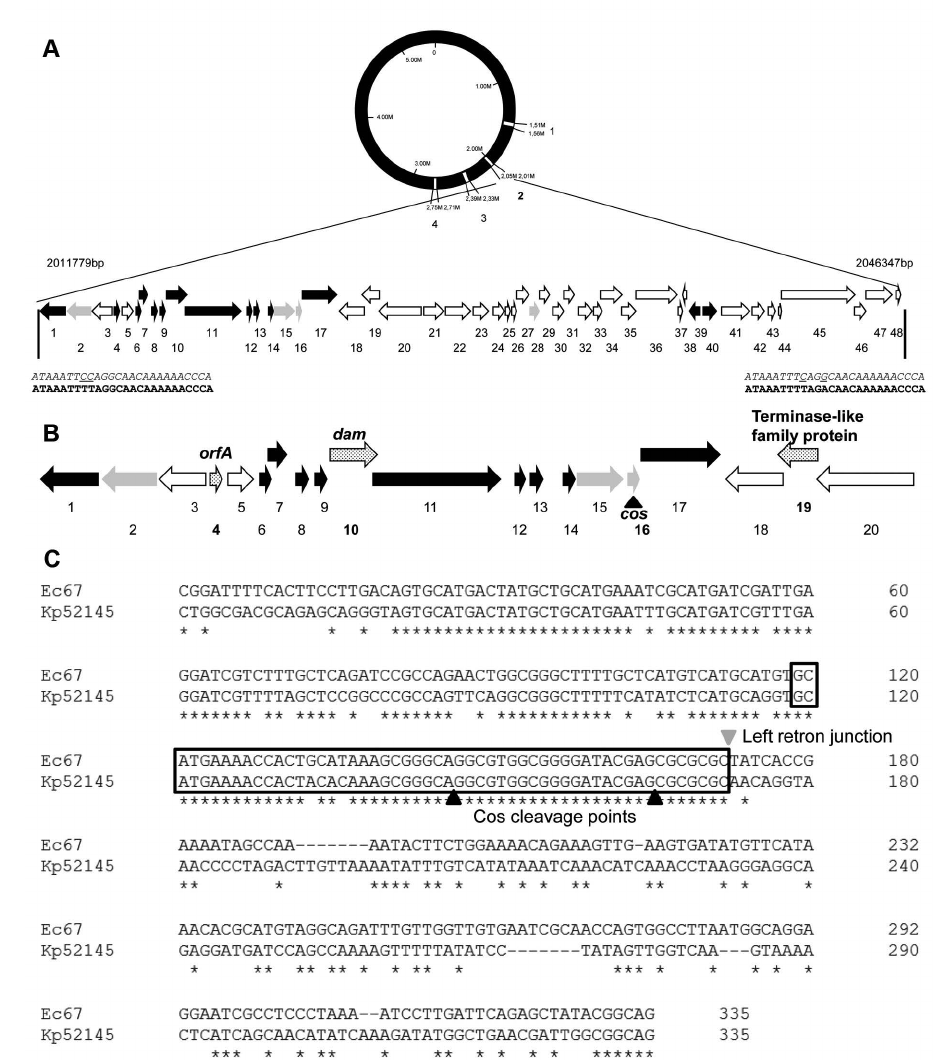
Figure 3. Region in the K. pneumoniae chromosome, and genes identified within, that is over-represented in populations that have evolved in presence of colistin. Panel B shows the localization of the other four prophages identified in K. pneumoniae kp52145. Panel A shows the genetic structure of the 34569 bp amplified region, correspondent to prophage 2. Arrows show the orientation of predicted open reading frames ORF. Hypothetical proteins (grey arrows), phage-related proteins (white arrows) and other functions (black arrows). Numbers under arrows are correlated with numbers in Table 3. The figure also shows the 26 bp direct repeats flanking this genomic region sequence. In bold, the sequences present in E. coli ; in italics, K. pneumoniae sequences. The nucleotides that differ between both microorganisms are underlined. Panel B shows the genomic region containing genes identified as related with retron Ec67; orfA , dam and Terminase-like family protein (dotted arrows), and the position of cos sequence (black triangle). C , alignment of conservative cos site (boxed) and cos cleavage points (black triangles) and retron junction (grey triangle) of Ec67 and K. pneumoniae kp52145 (Clustal OMEGA